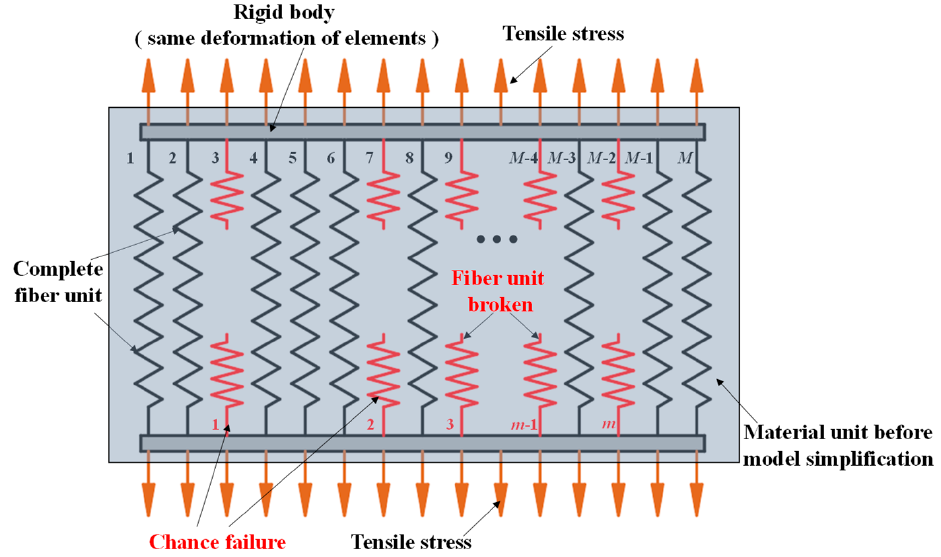
Figure 17. Tensile fiber bundle